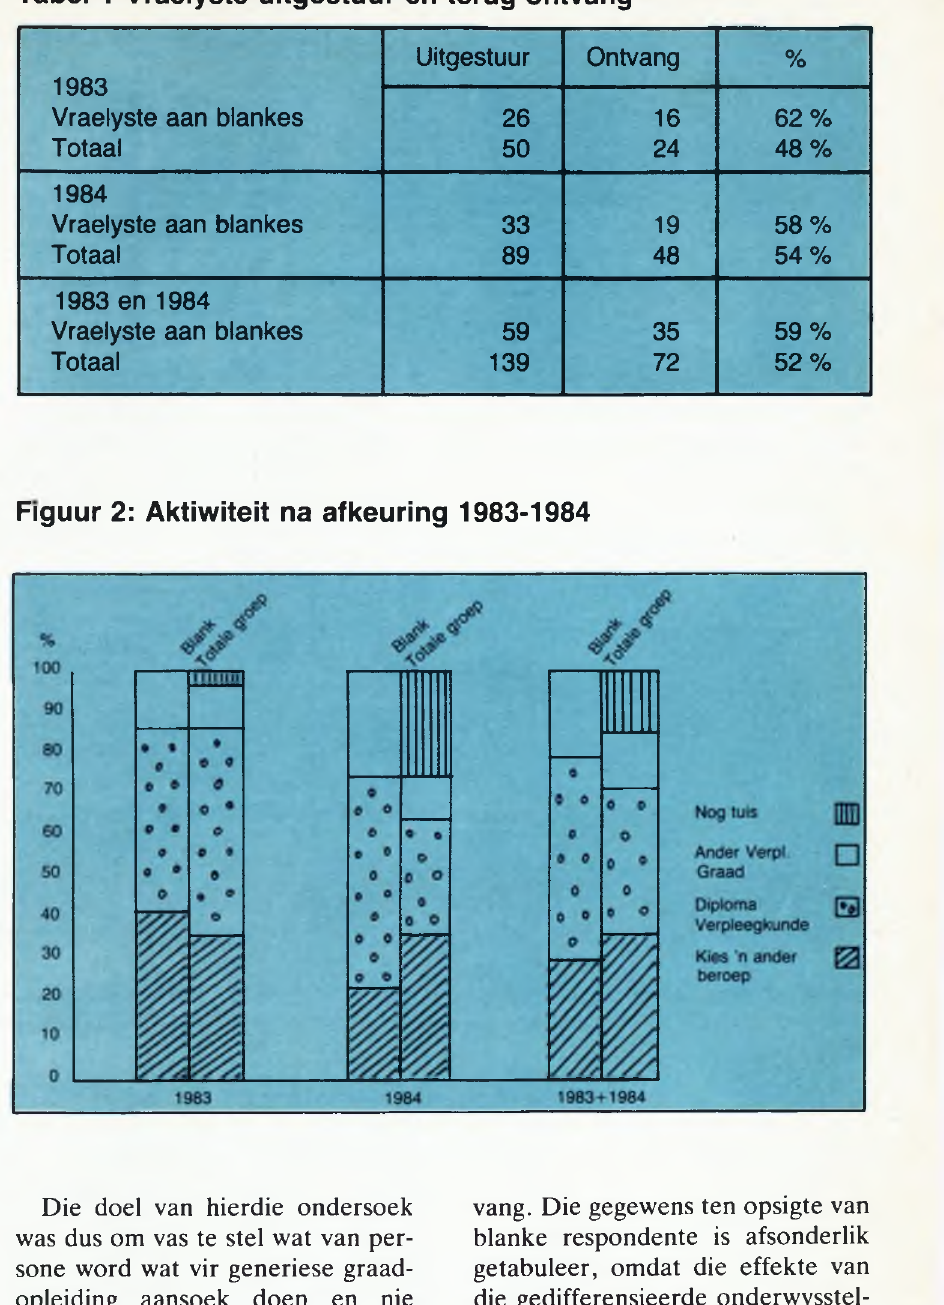
Figuur 2: Aktiwiteit na afkeuring